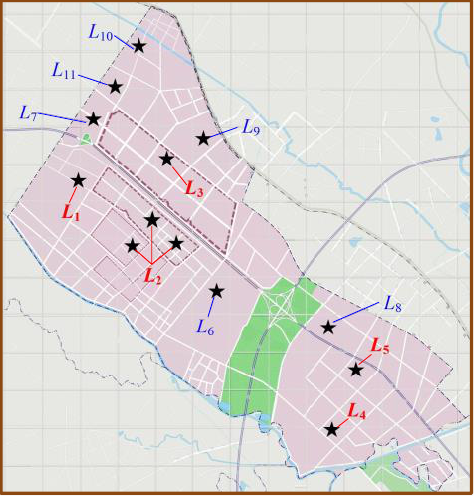
Figure 6. Brief geography diagram of the high-tech manufacturers (HTMs) in the park.